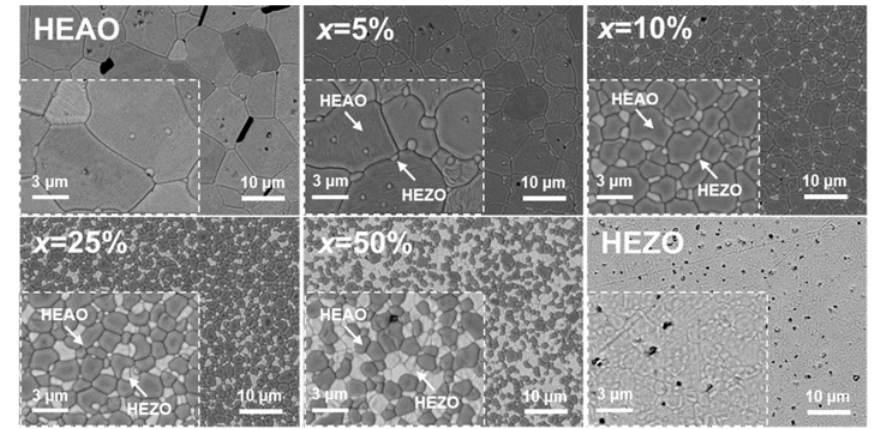
Fig. 2 Microstructures of the obtained HEAO particulate composites with different contents of HEZO phase.